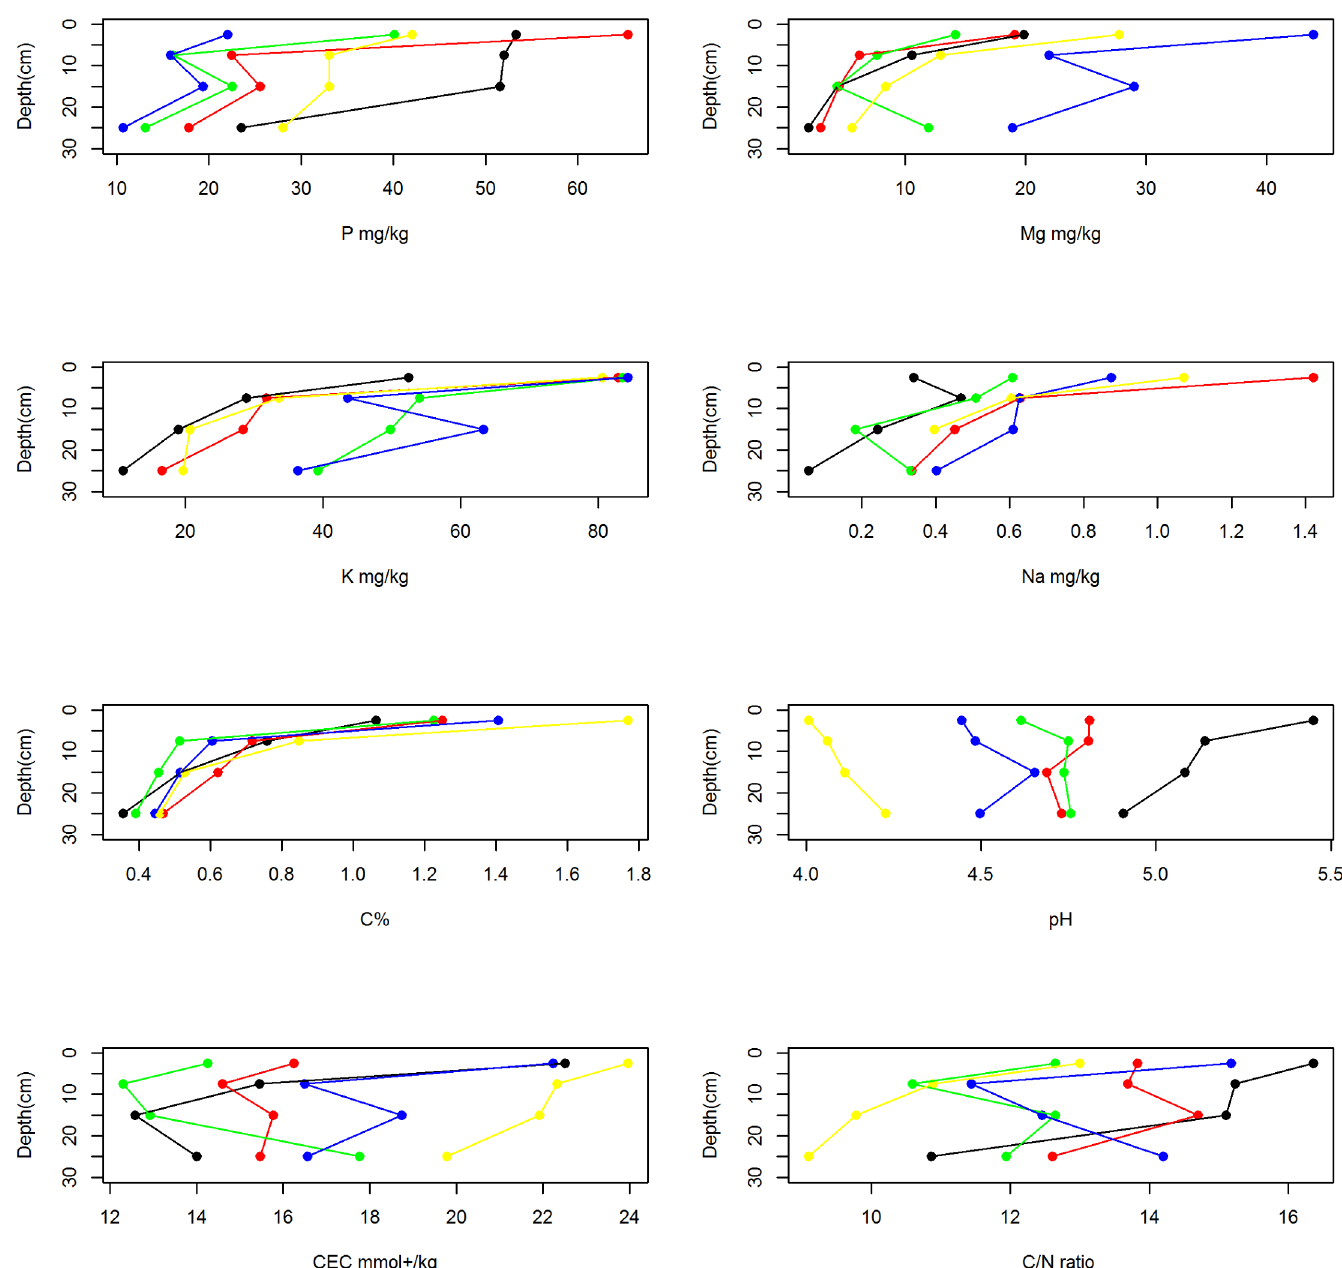
Fig 3. Changes in soil characteristics with increasing depth per forest type (mean plotted). Note that black dots refer to savanna, red dots: colonising forest (F1), green dots: monodominant Okoume forest (F2), blue dots: young Marantaceae forest (F3) and yellow dots: mixed Marantaceae forest